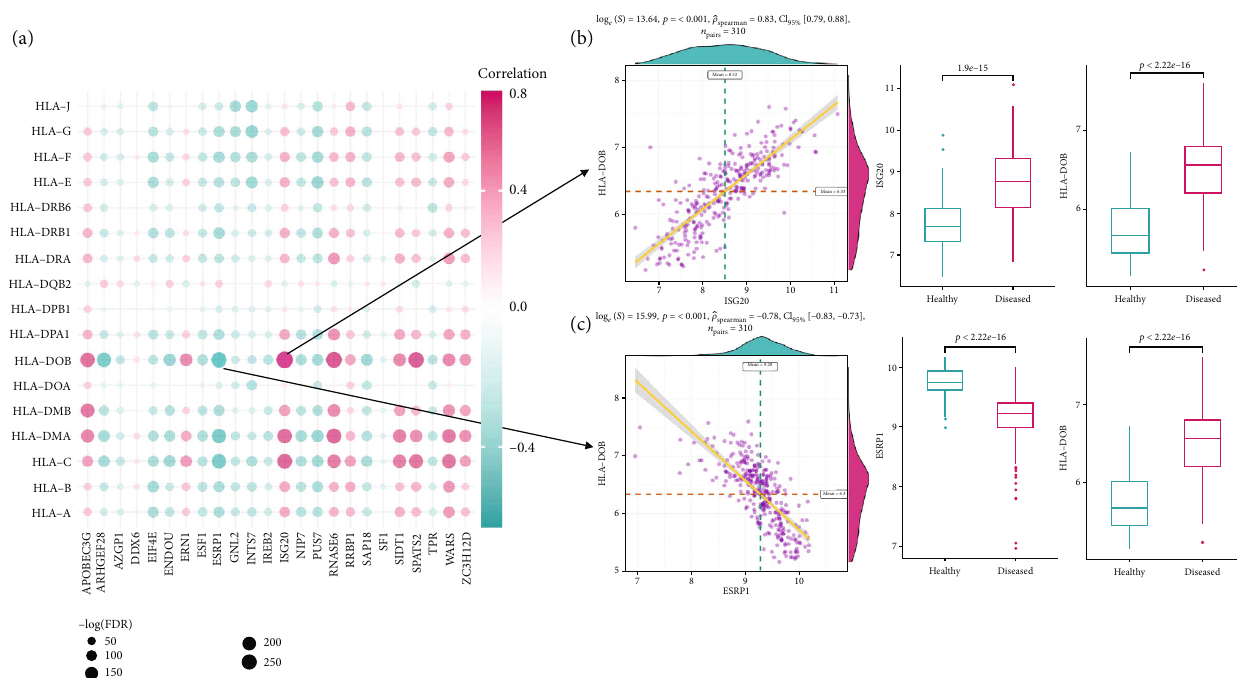
Figure 5: HLA expression status in periodontitis and their correlation with RBPs. (a) Correlation analysis between HLA and RBP expression levels. (b) Dot plot and box plot reveal the relationship between the most positively correlated HLA-RBP pair, HLA-DOB, and ISG20. Higher expressions of HLA-DOB and ISG20 were observed in periodontitis samples. (c) Dot plot and box plot reveal the relationship between the most negatively correlated HLA-RBP pair, HLA-DOB, and ESRP1. Higher expression of HLA-DOB and lower expression of ESRP1 were observed in periodontitis